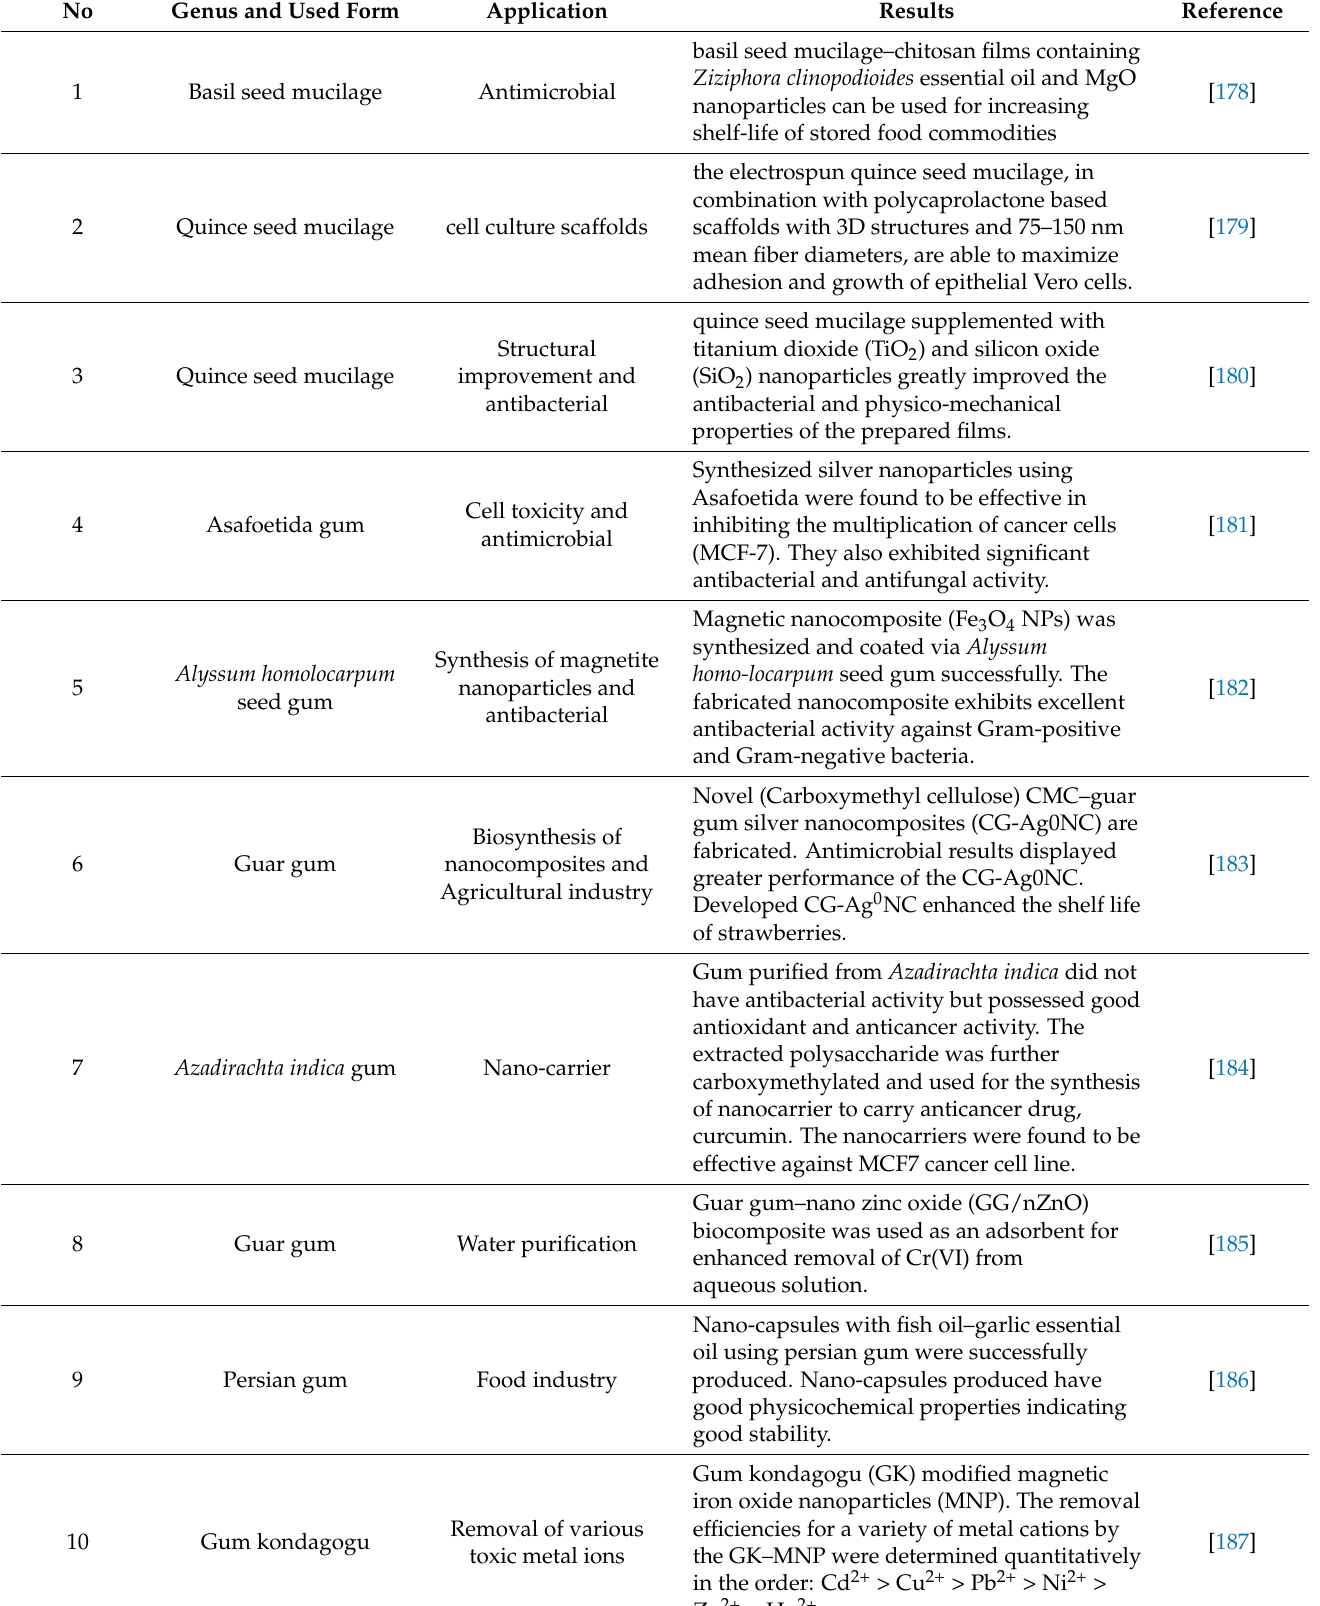
Table 3. Some applications of gums and mucilages in